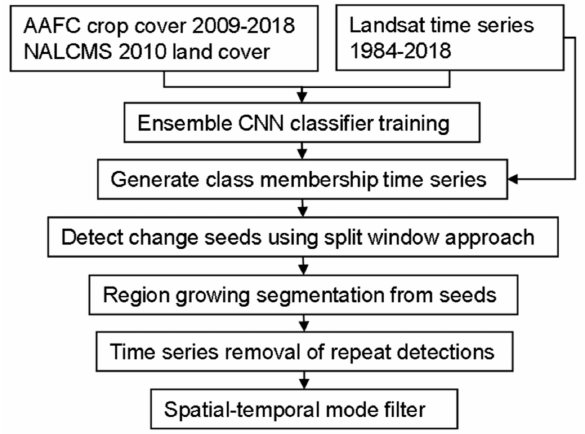
Figure 1. Overview of processing